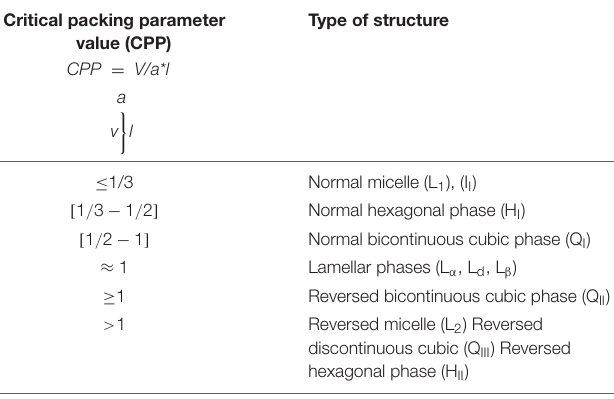
TABLE 1 | Dependence of the lipid self-assembly structures on the value of the critical packing parameter (CPP). Critical packing parameter value